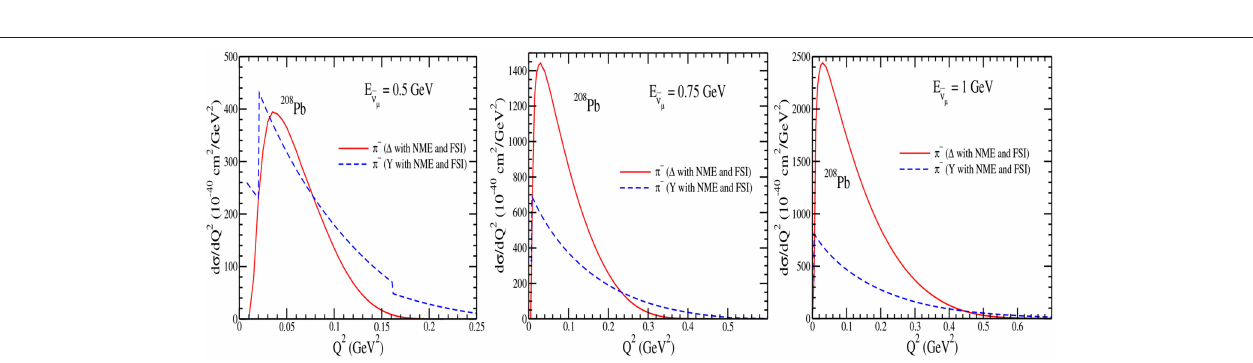
FIGURE 24 | d σ vs Q 2 at E ν µ = 0.5 GeV (left) , 0.75GeV (middle) , and 1GeV (right) in 208 Pb. Lines and points have the same meaning as in Figure 21 . dQ 2 ¯